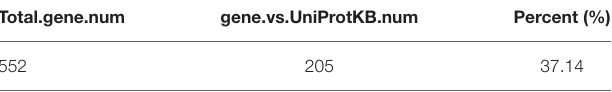
TABLE 10 | Gene annotation rate statistics.